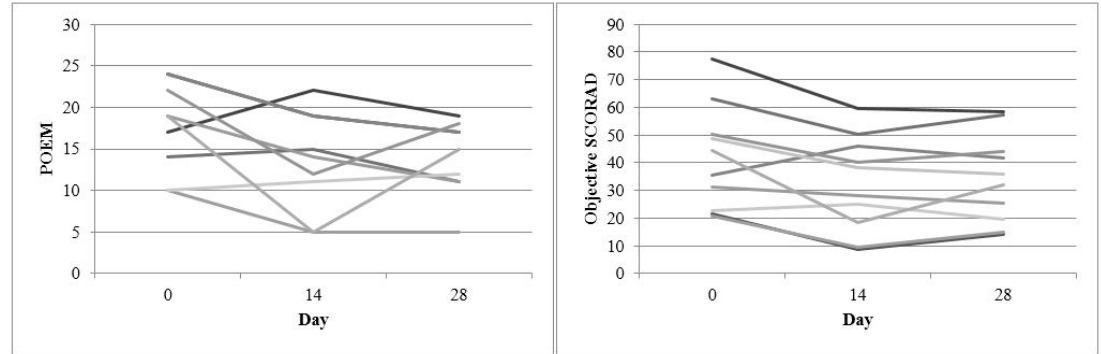
Figure 1. Disease severity change over four weeks (POEM and Objective SCORAD) for the pine-tar bath study.